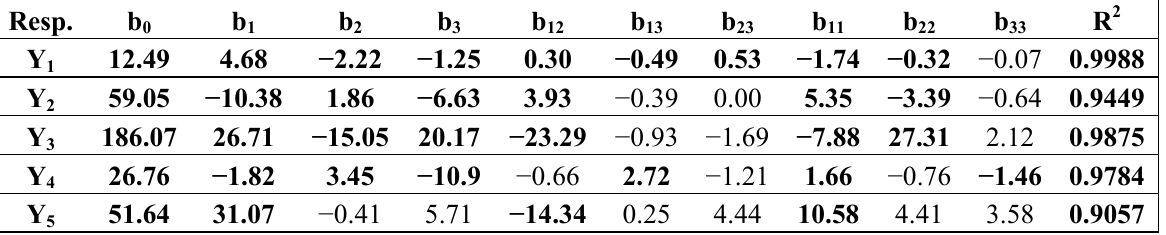
Table 4 . Coefficients for the mathematical models. Linear (b and quadratic (b (Y –Y 1 5